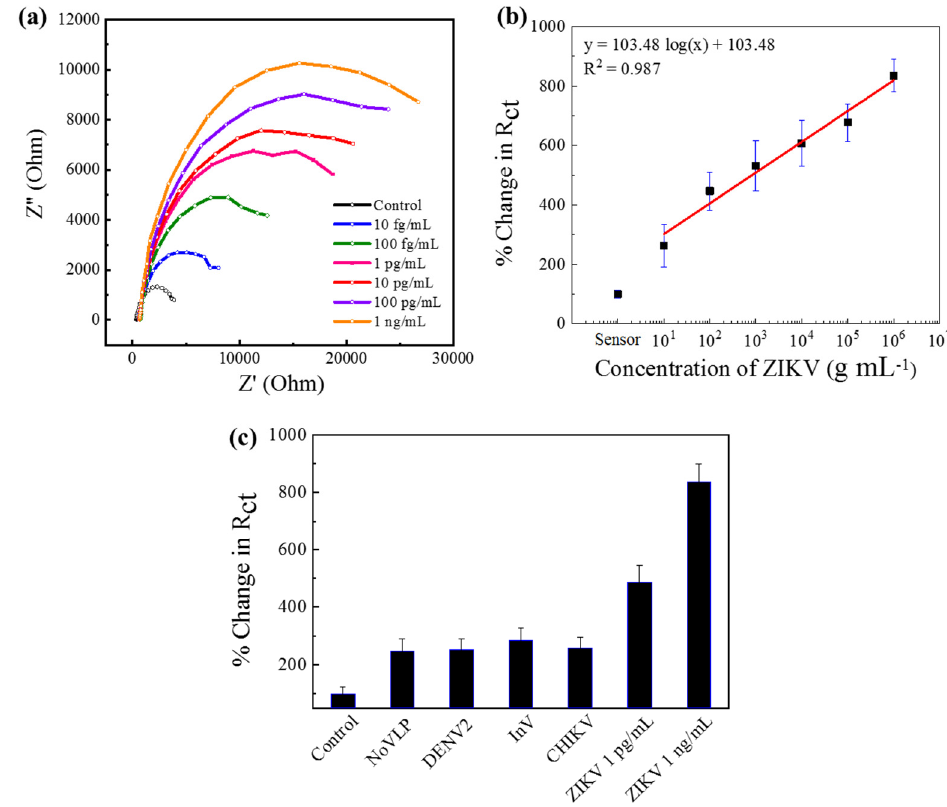
Figure 3. Au|PAni|Au-PAni-N,S-GQD-Ab ZIKV sensor performances in different concentrations of ZIKV analytes (10 fg mL − 1 –1 ng mL − 1 ). ( a ) Nyquist plots, ( b ) calibration line for percentage change in R ct vs. ZIKV concentration, ( c ) selectivity of the proposed sensor with 10 pg mL − 1 of NoV-LP, DENV-LP-2, Influenza virus A (H1N1), and ZIKV along with 1 pg mL − 1 , and 1 ng mL − 1 target CHIKV. Error bars represent the standard deviations of triple measurements.